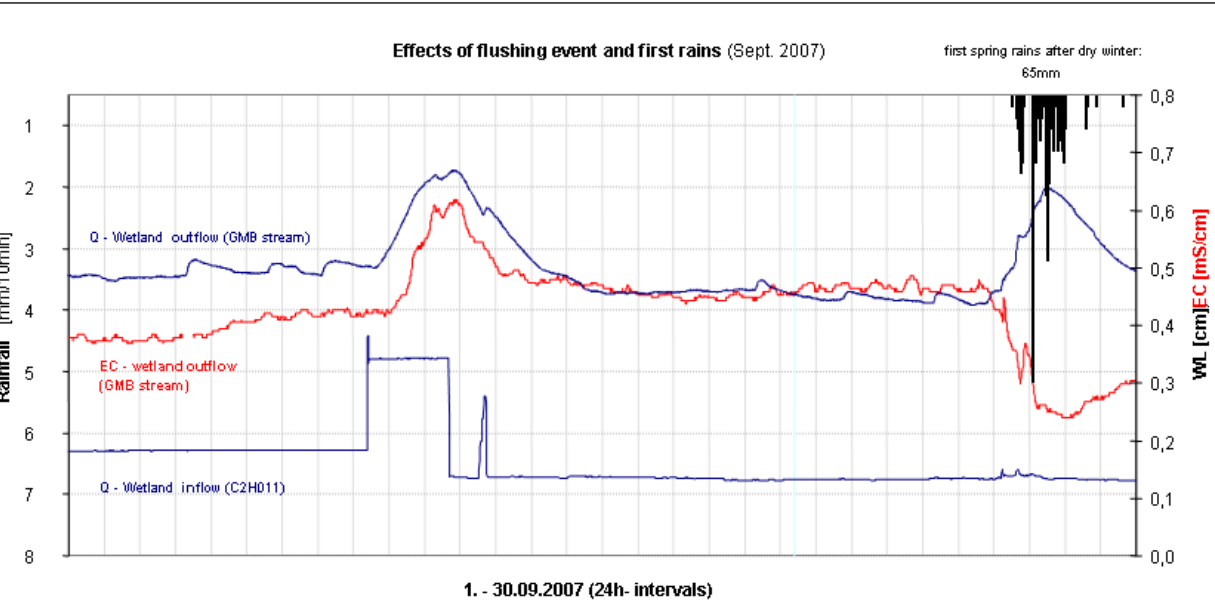
Figure 21. Changes in water level and EC of the GMB stream at the outflow of the wetland in response to the discharge of additional water into the wetland (flushing event) and the first spring rains (September